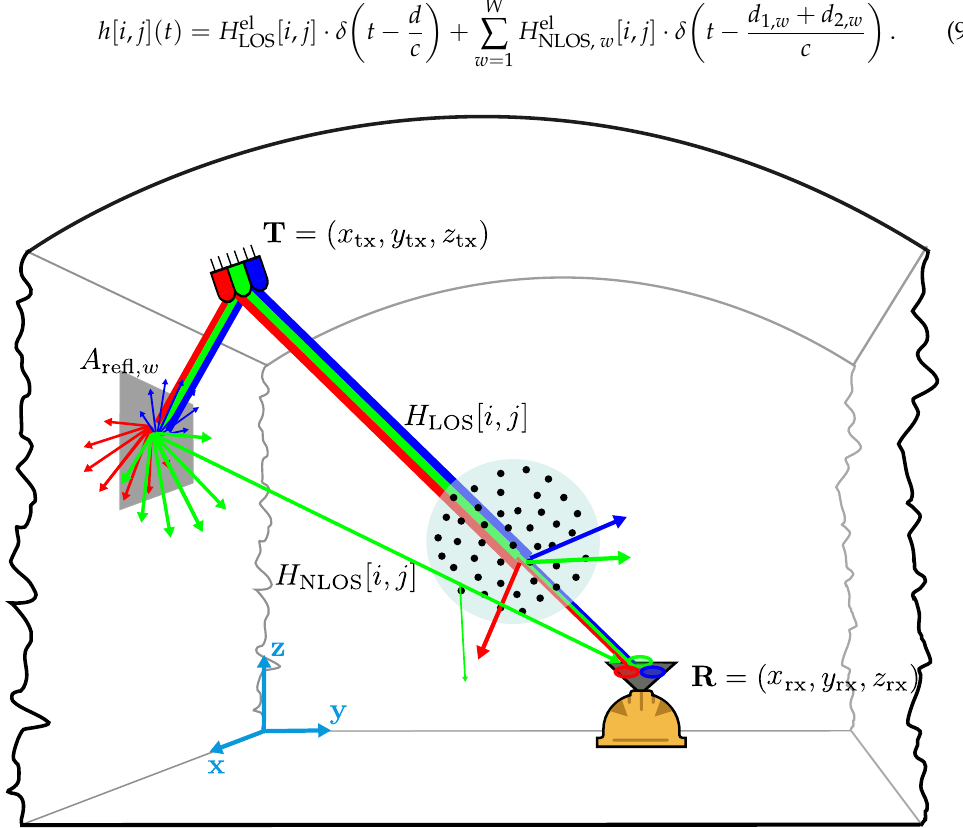
Figure 3. Proposed CSK-based UM-VLC channel